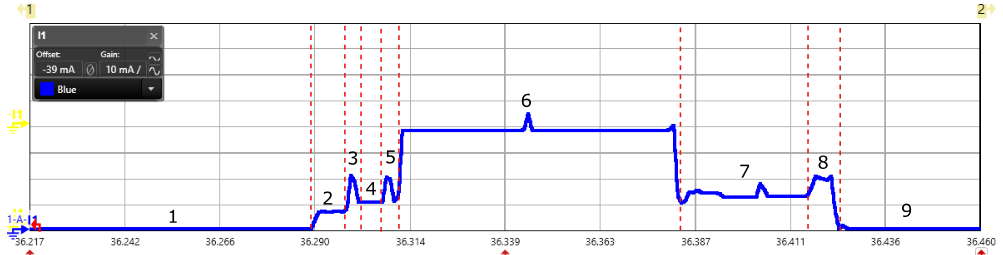
Figure 11. DASH7 communication model.